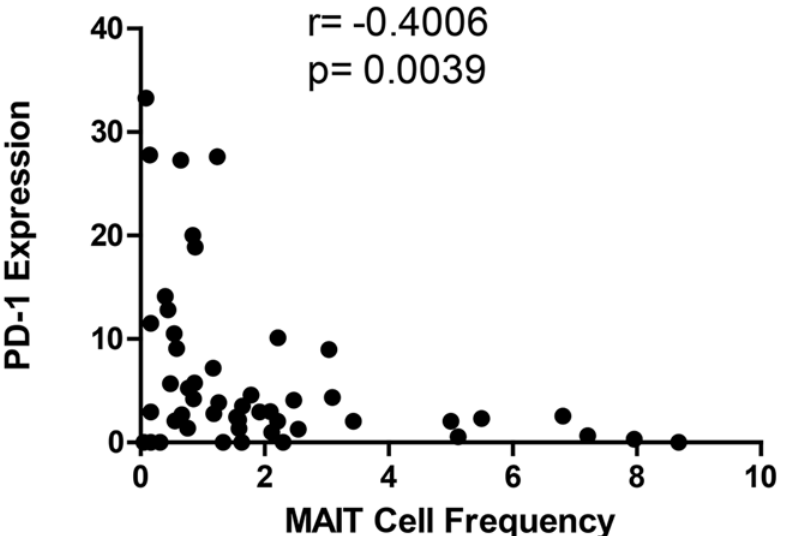
Fig 5. Correlation analysis between PD-1 expression and CD161 ++ /MAIT cell frequency in the study participants. The MAIT cells frequency correlated inversely with PD-1 expression on MAIT cells ( P = 0.0039 and r = -0.4006). Correlation analysis between CD161 ++ /MAIT cell frequencies and PD-1 expression was performed using the Spearman's rank correlation